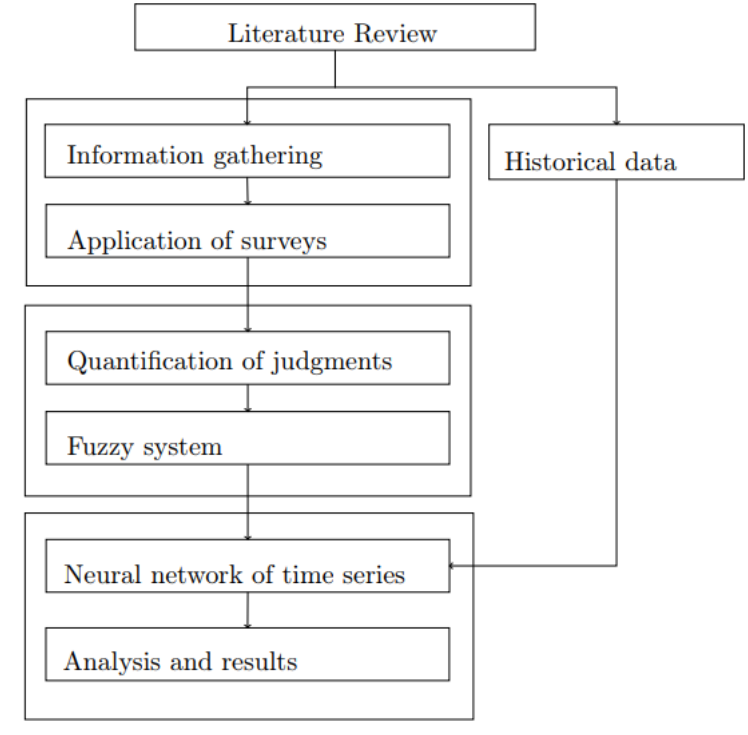
Figure 1. Proposed